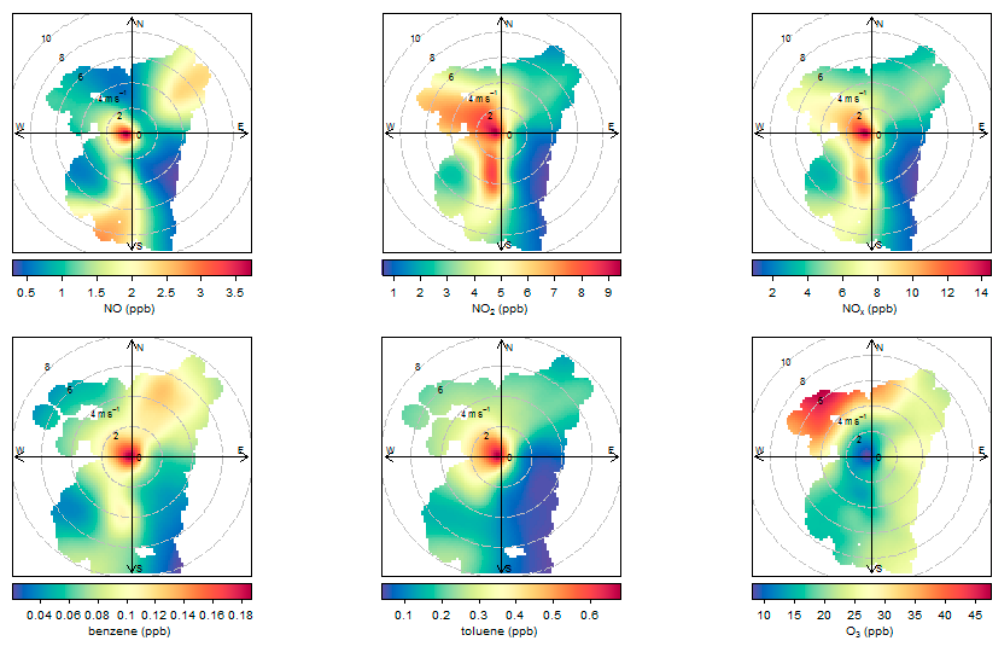
Figure 5. Bivariate polar plots showing how mole fractions (ppb) of different trace gases vary as a function of wind speed (m · s − 1 ) and wind direction at the main MUMBA site during the campaign.